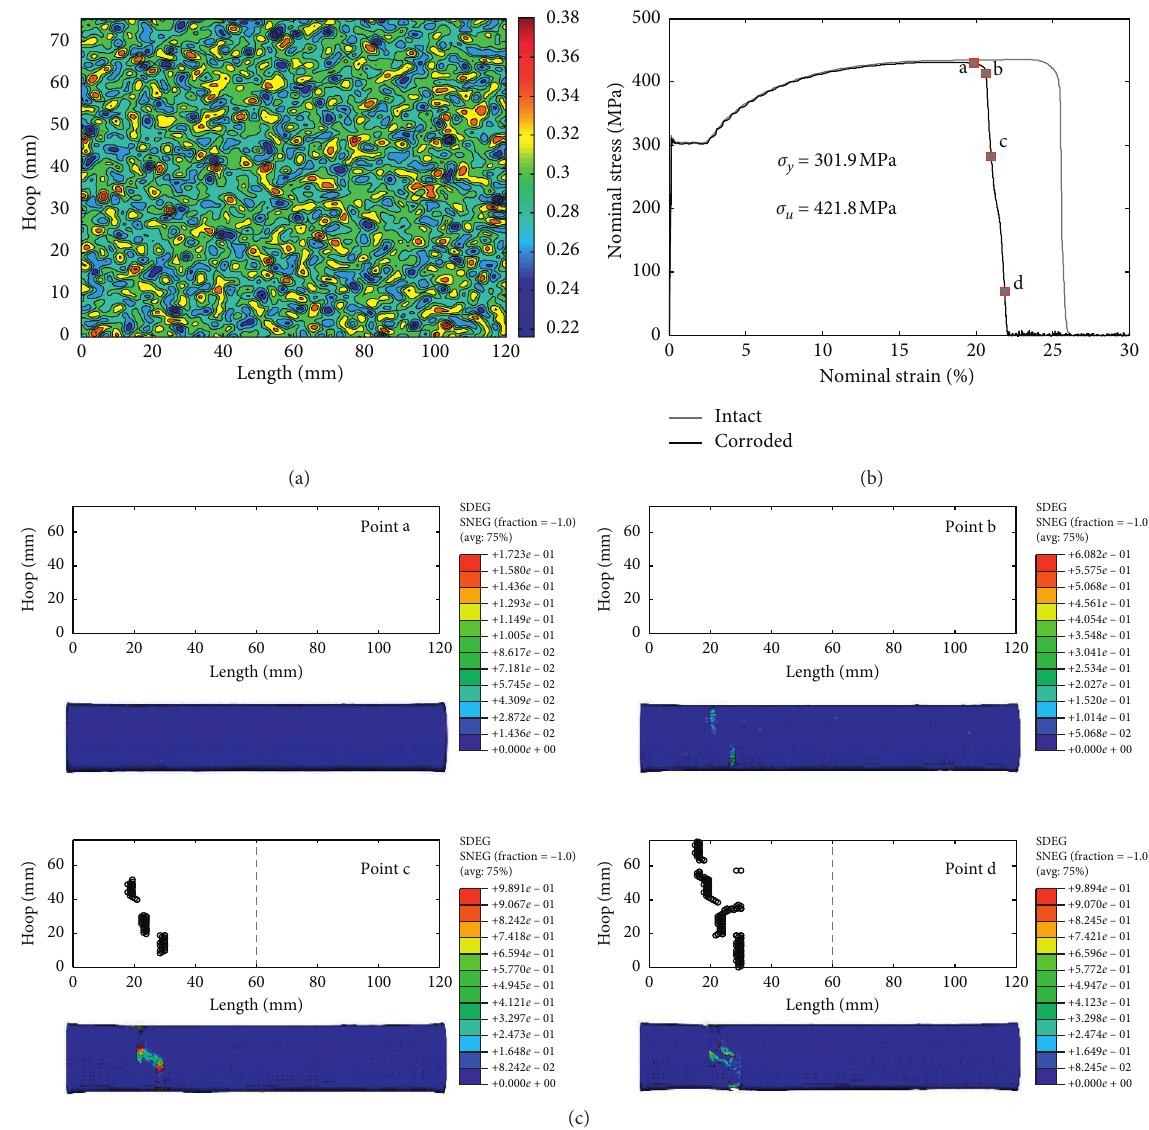
Figure 12: Damage evolution and fracture mode of a corroded pipe. (a) Random field with a value of η � 70% andvar � 0 . 02 mm, (b) stress- strain curve, and (c) crack propagation at points marked in